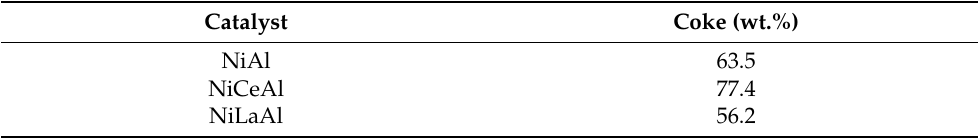
Table 3. Coke formation on spent catalysts measured by TGA